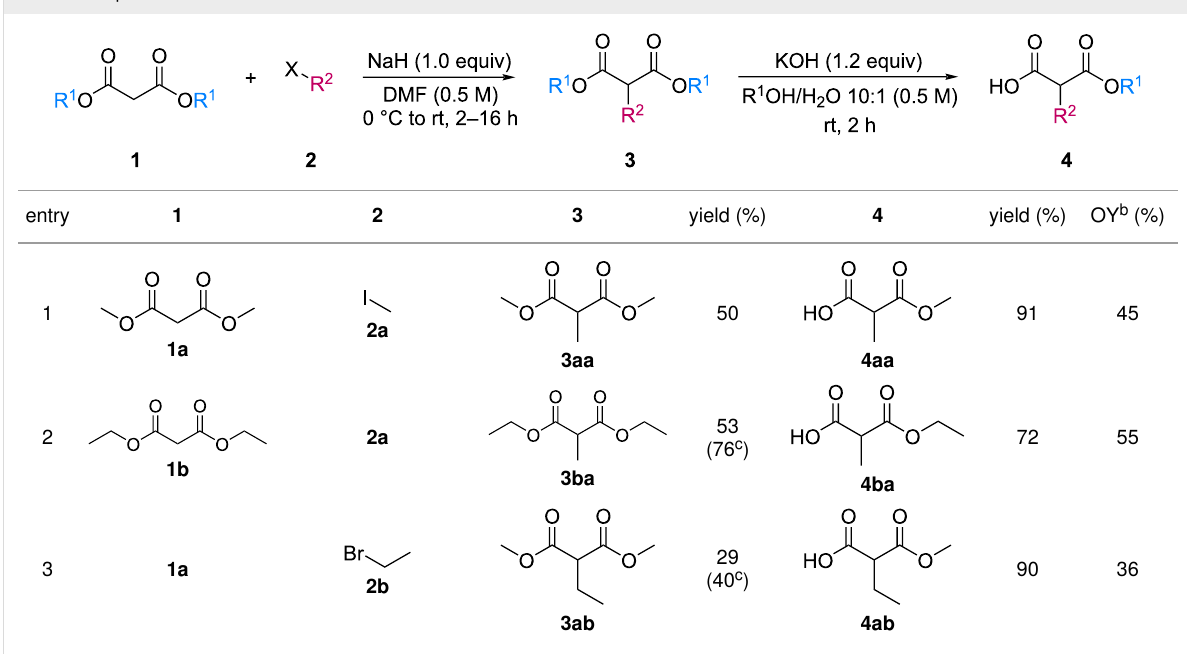
Table 2: Preparation of SMAHOs from malonates a